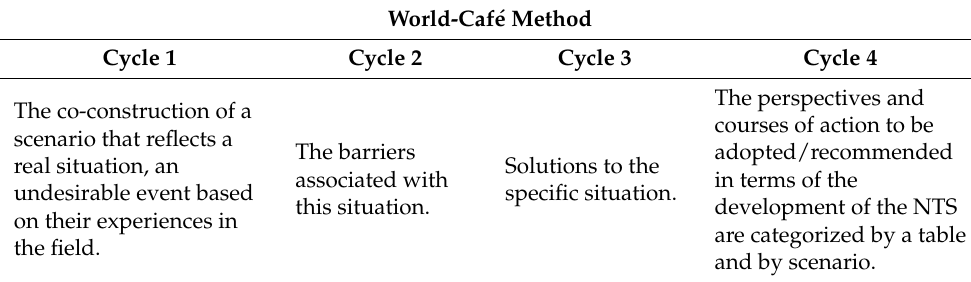
Table 1. The four cycles of World Caf é method.